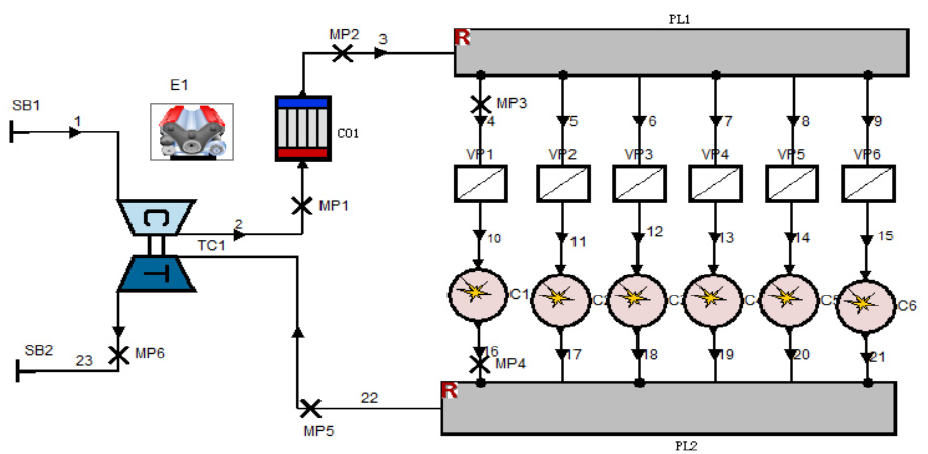
Figure 2. 6S50 ME-C-GI engine model in the AVL-BOOST environment. Table 2. The main definitions of the symbols.